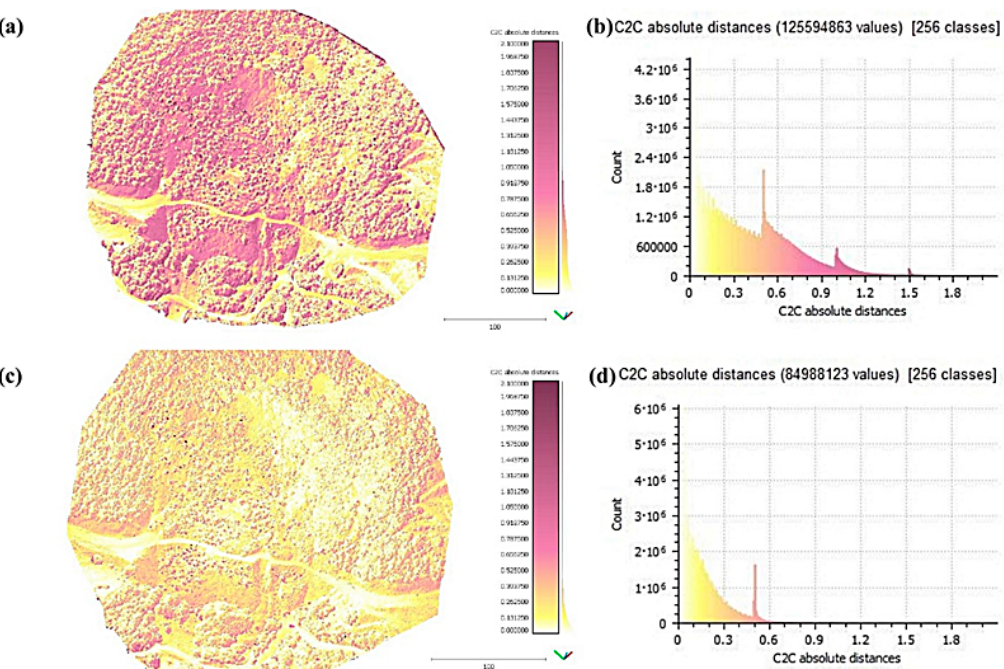
Figure 10. Cloud-to-cloud distances. ( a ) C2C distances between the point cloud of nadir-oblique imagery and the corresponding one of nadir-viewing geometry, acquired on 9 June 2018. ( b ) Histogram of C2C distances between the point cloud of nadir-oblique imagery and the corresponding one of nadir-viewing geometry, acquired on 9 June 2018. ( c ) C2C distances between the point cloud of nadir-oblique imagery and the corresponding one of oblique-viewing geometry, acquired on 9 June 2018. ( d ) Histogram of C2C distances between the point cloud of nadir-oblique imagery and the corresponding one of oblique-viewing geometry, acquired on 9 June 2018.